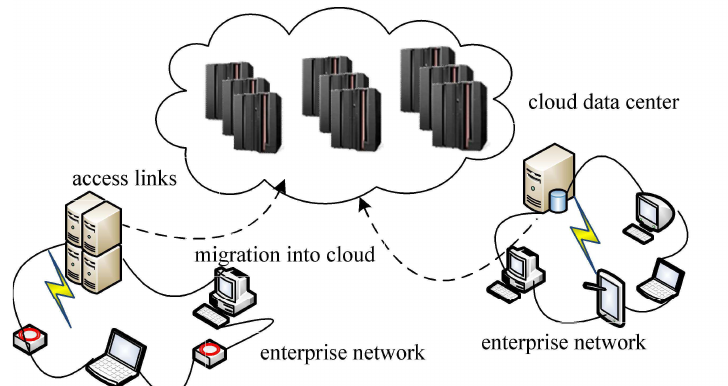
Figure 1. Architecture of enterprise applications migration into cloud.